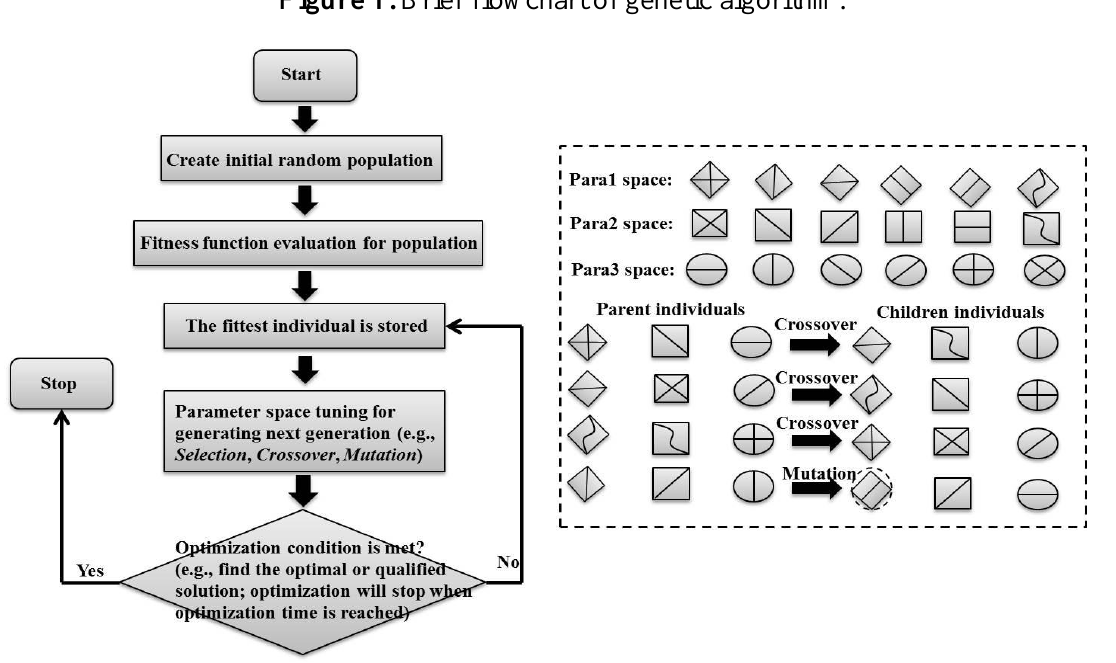
Figure 1. Brief flowchart of genetic